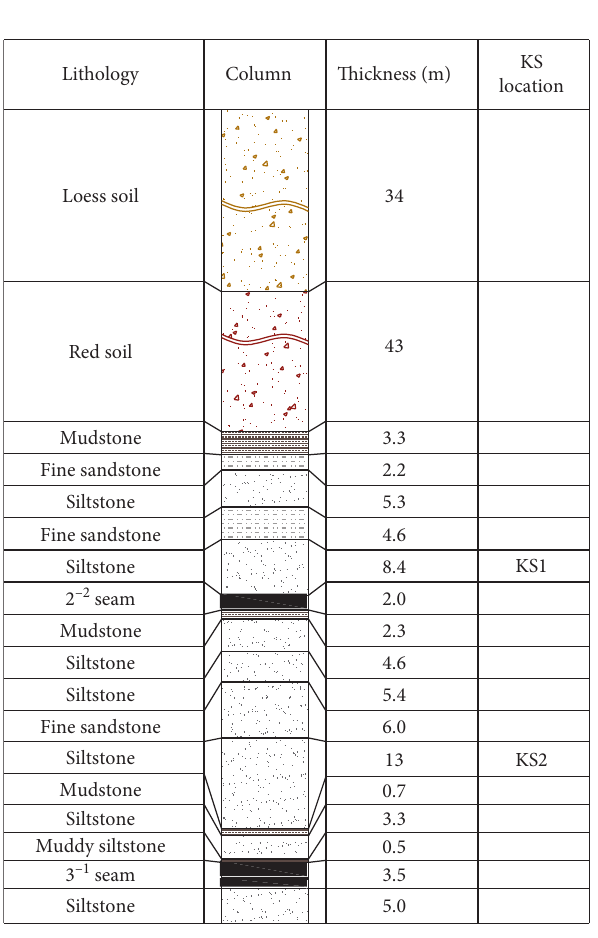
Figure 2: Column of overlying strata in No. 30105.